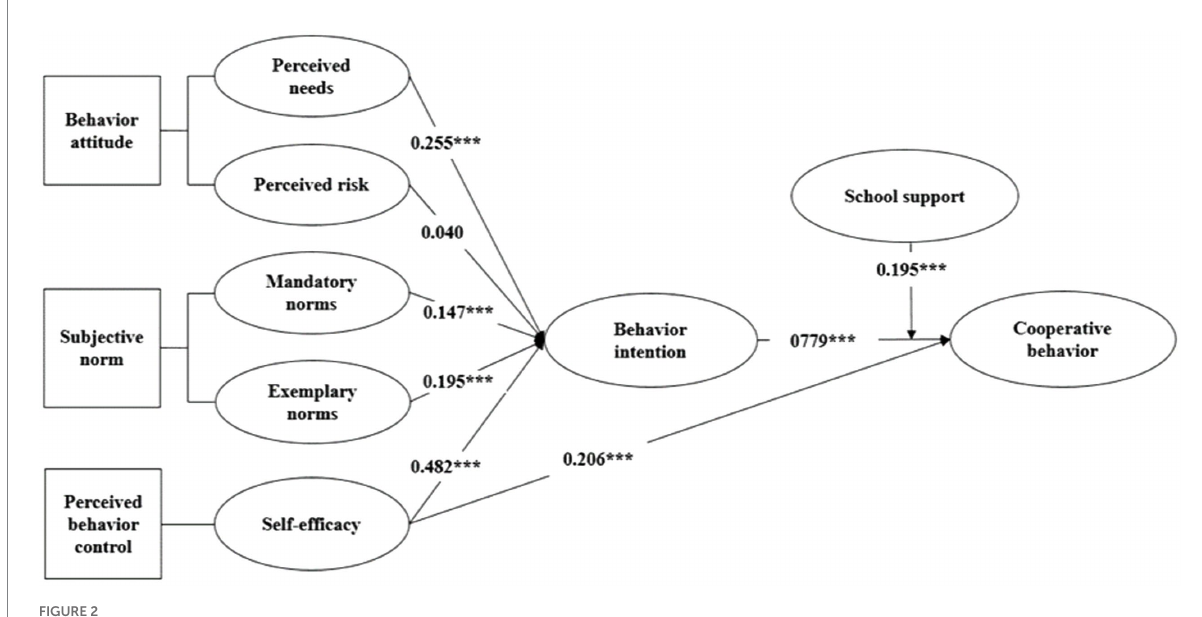
FIGURE 2 The results of the research model. *** p <